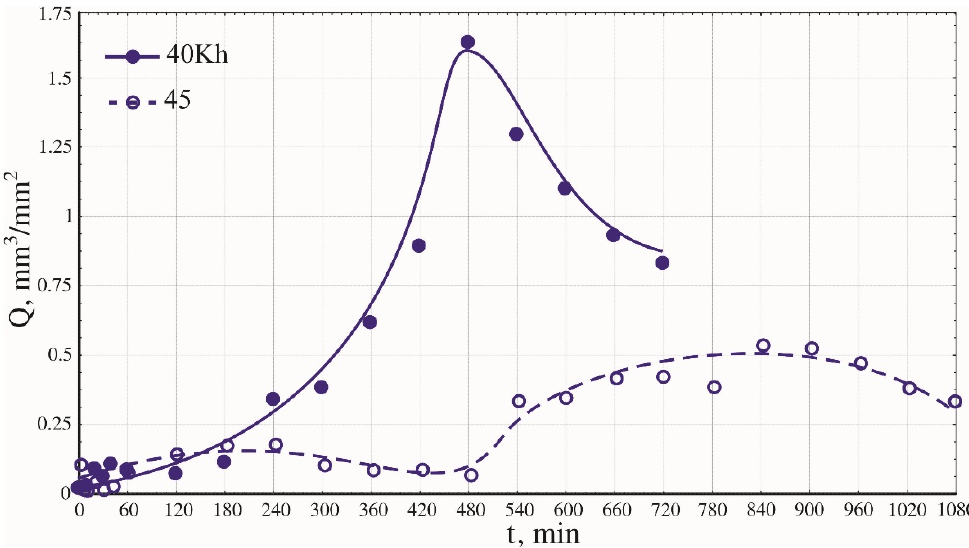
Figure 10. Dynamics of changes in surface oil capacity.